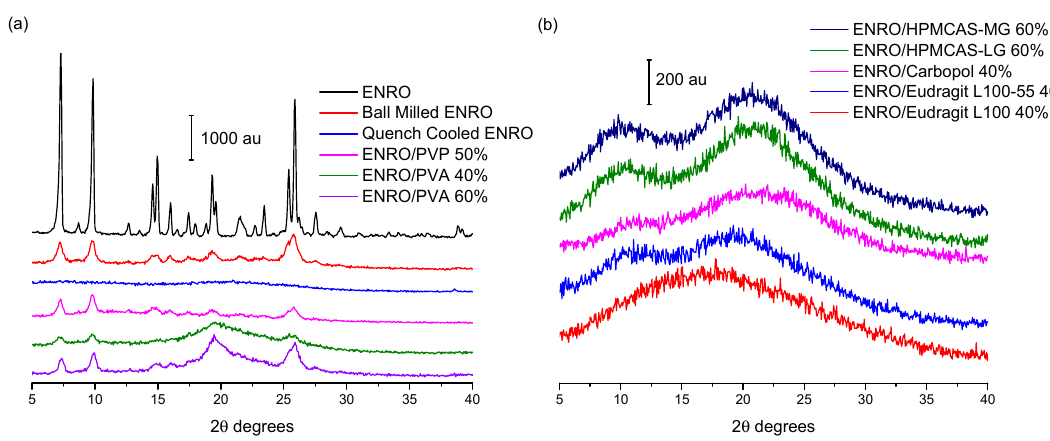
Powder X-ray di ff raction (PXRD) di ff ractograms of ( a ) enrofloxacin (ENRO) and Figure 2. Powder X-ray diffraction (PXRD) diffractograms of ( a ) enrofloxacin (ENRO) and semi- semi-crystalline solid dispersions, and ( b ) ENRO amorphous solid dispersions crystalline solid dispersions, and ( b ) ENRO amorphous solid dispersions (ASDs).